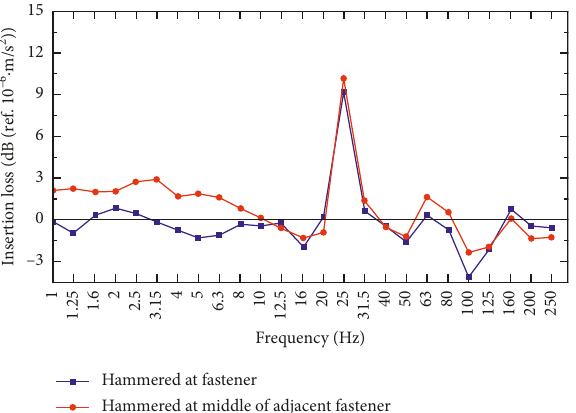
Figure 15: Insertion loss at track foundation measurement points with and without vibration absorbing